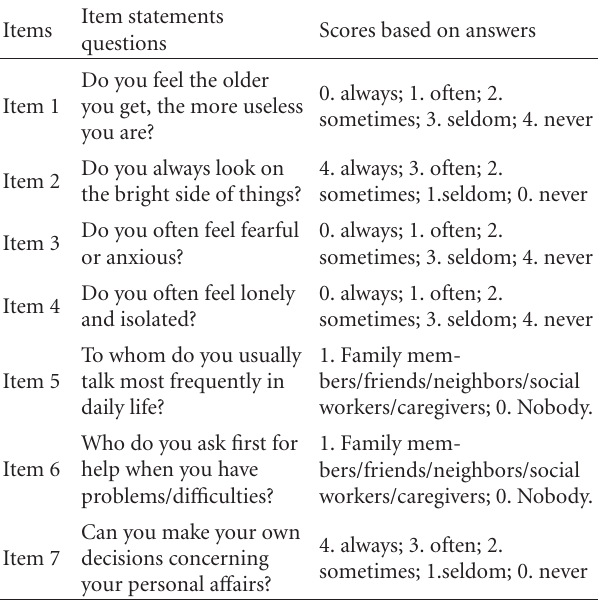
Table 2: Measures of resilience: questions of the seven items asked in the CLHLS